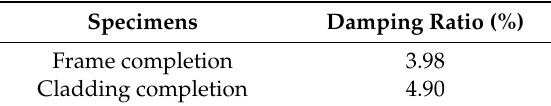
Figure 13. Damping ratio (cladding completion). Table 7. Damping ratio of specimens.